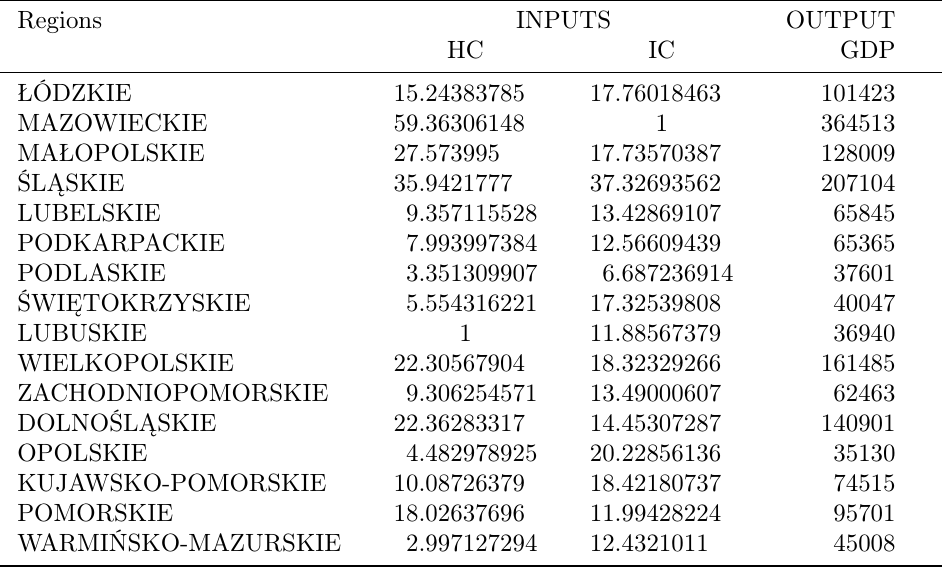
Table 1: The multivariate database (reduced into a single-period database with two independent factors by means of a PCA) for the 16 voivodships in Poland 5